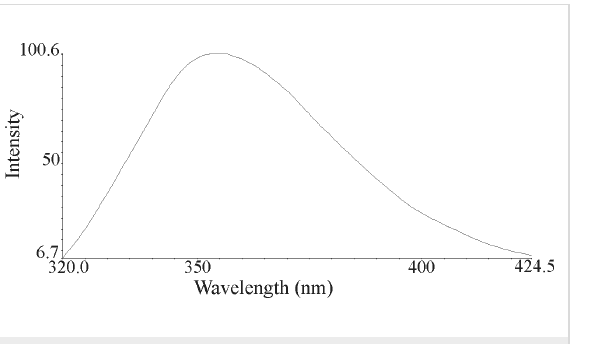
Figure 10: Fluorescence spectrum of compound 4 in methanol.